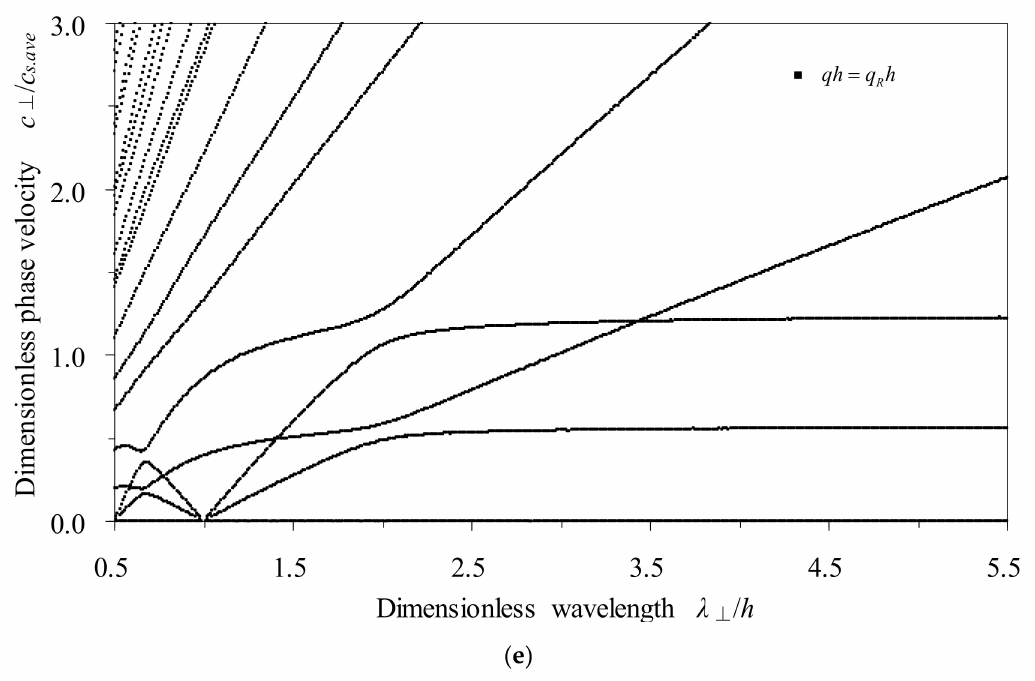
Figure 4. The comprehensive dispersion curves in low frequency range of Floquet in–plane waves propagating along the direction perpendicular to layering in the exemplified periodic octal–layered media. The frequency–related dispersion curves: ( a ) the frequency–wavenumber spectra, ( b ) the frequency–wavelength spectra, and ( c ) the frequency–phase velocity spectra. The phase velocity– related dispersion curves: ( c ) the frequency–phase velocity spectra, ( d ) the wavenumber–phase velocity curves, and ( e ) the wavelength–phase velocity curves.